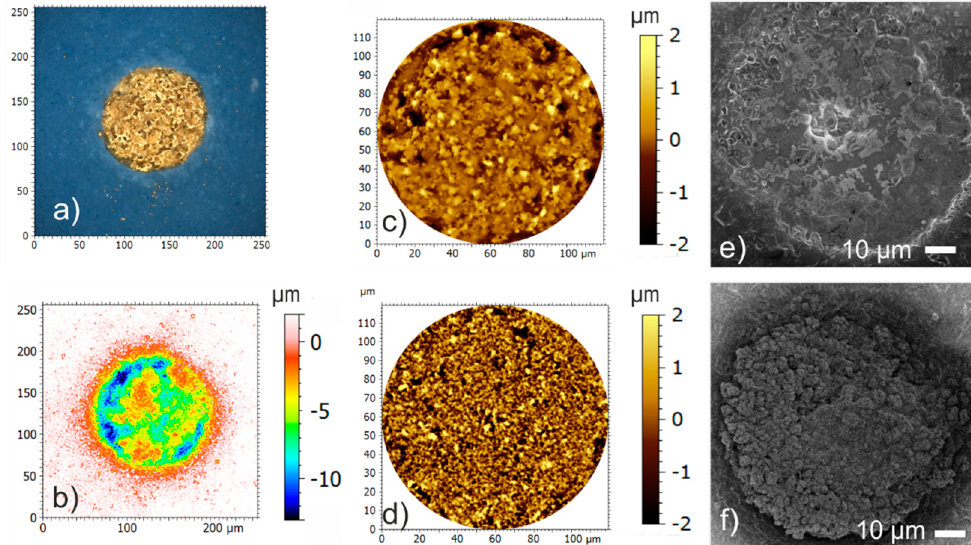
Figure 2. Surface morphology of thick film electrodes: ( a ) laser scanning microscopy (LSM) micrograph of thick film gold electrodes (TFGe); ( b ) contour map of the typical surface topography; ( c ) surface roughness image of TFGe (Sq = 0.484) and ( d ) of TFGe coated with PEDOT (PEDOTe) (Sq = 0.939); ( e ) SEM micrograph of the surface structure of TFGe and ( f ) of PEDOTe. PEDOT = poly(3,4-ethylenedioxythiophene